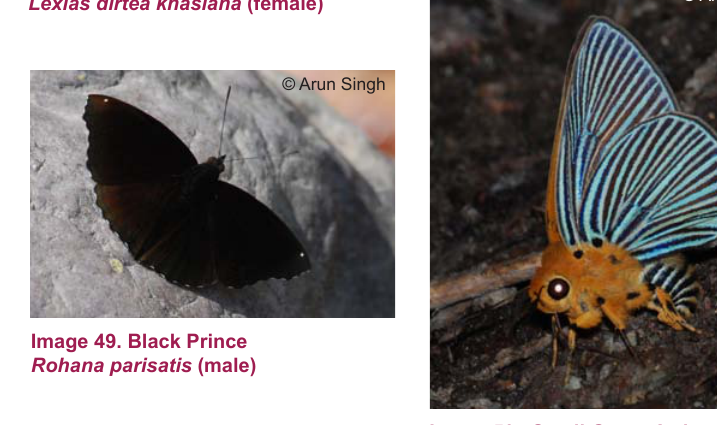
Image 50. Small Green Awlet Burala amara